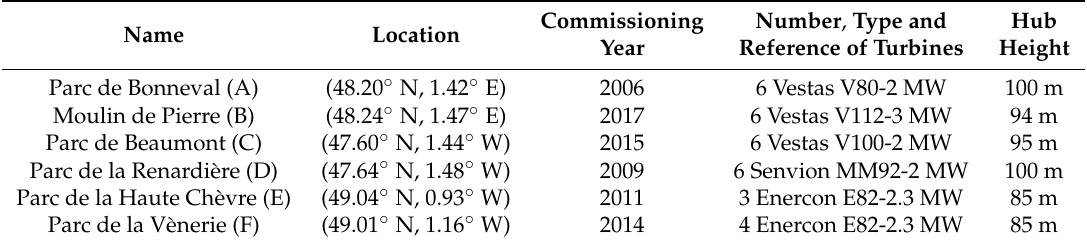
Table 1. Main characteristics of the 6 considered wind farm including: the location, the commissioning year, the number, type and reference of the wind turbines and the hub height.